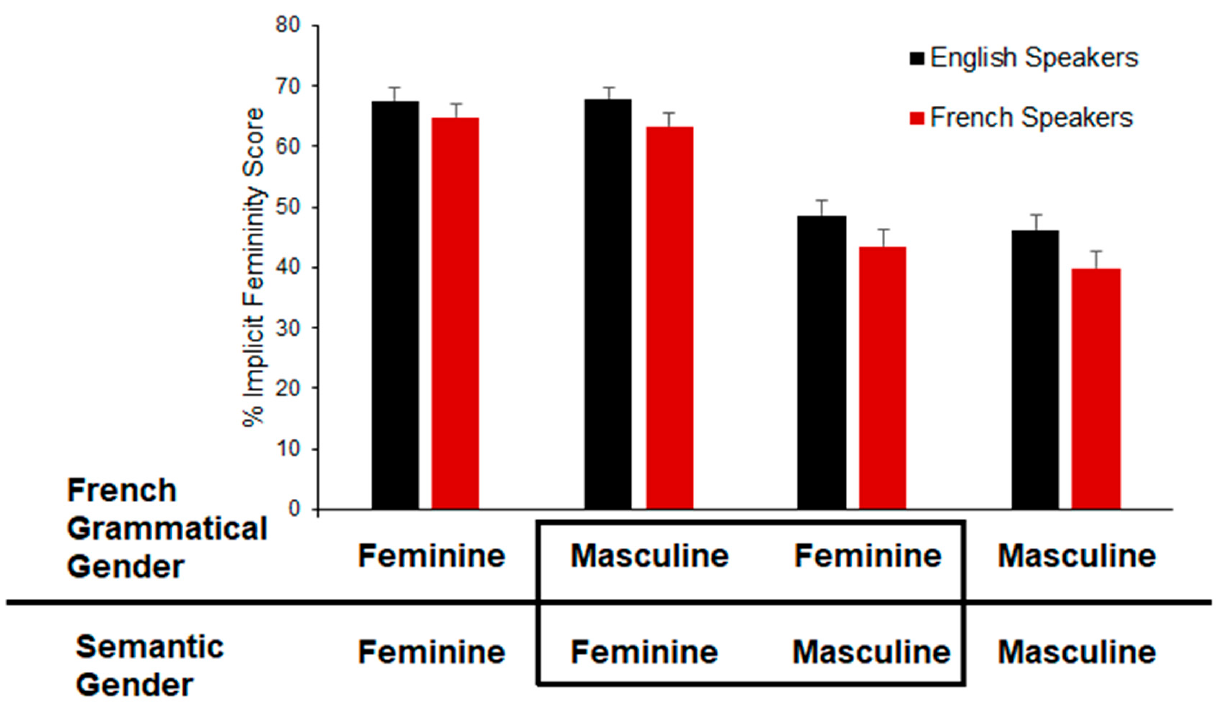
Figure 1. The areas in the box on the x-axis indicate the odorants that are mismatched between semantic gender and French grammatical gender. The bars reflect the mean implicit femininity score, and the error bars represent the standard error.